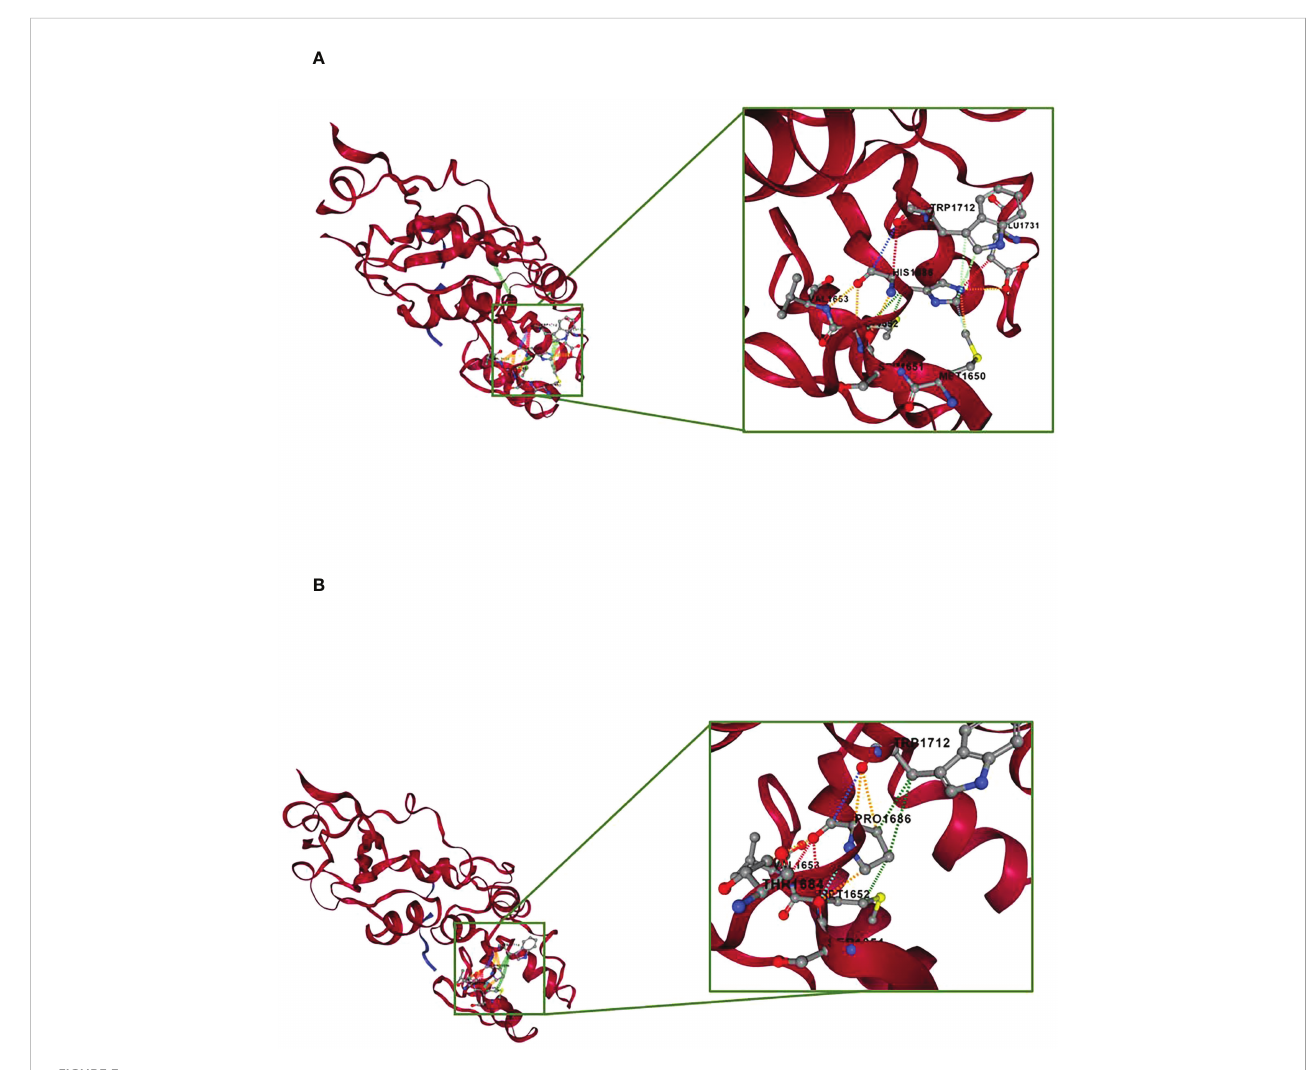
FIGURE 3 Prediction of molecular stability by DynaMut. The protein portion concerned by the point mutation is zoomed and depicted in the framed box. (A) Structural prediction of the BRCA1 wild-type protein. (B) Structural prediction of the BRCA1 p.His1686Pro protein. The interactions occurring between the p.His1686 residue and the neighbor residues are showed as colored dashed lines. Red, H-bond; orange, polar interactions; yellow, ionic interactions; cyan, van der Waals; light green, aromatic interactions; dark green, hydrophobic